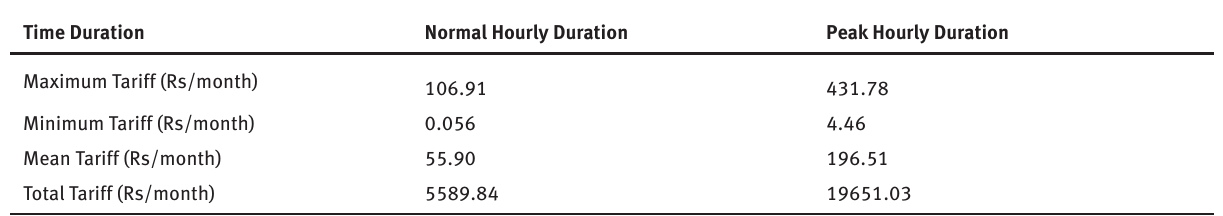
Time Duration Normal Hourly